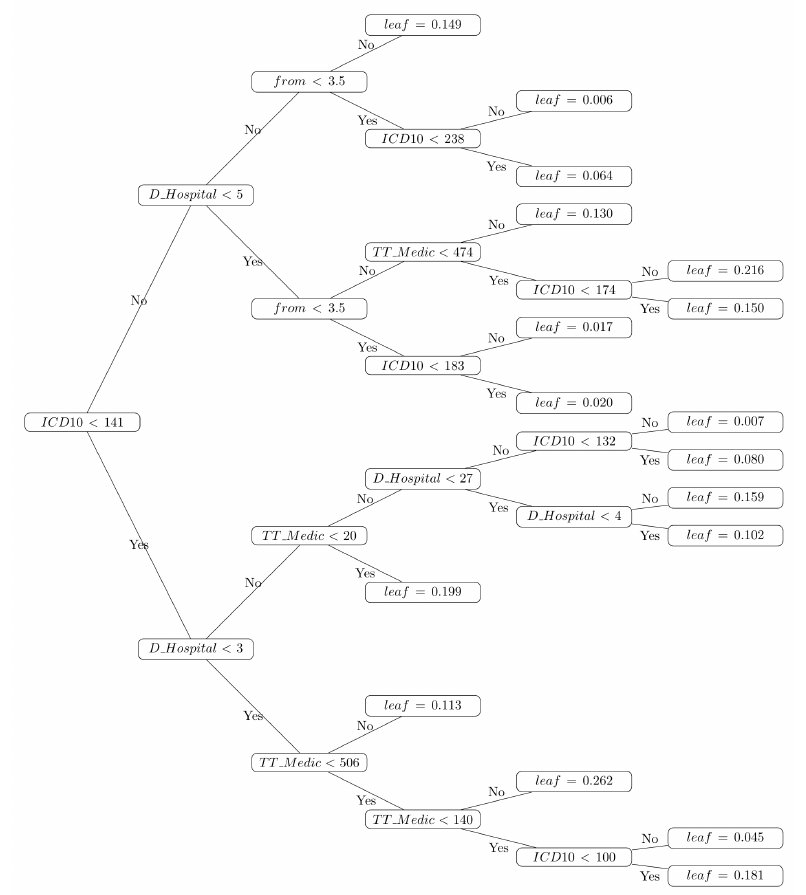
Figure 6. Exemplar of the resulting DT that provides treatment and diagnosis information retrieved from training